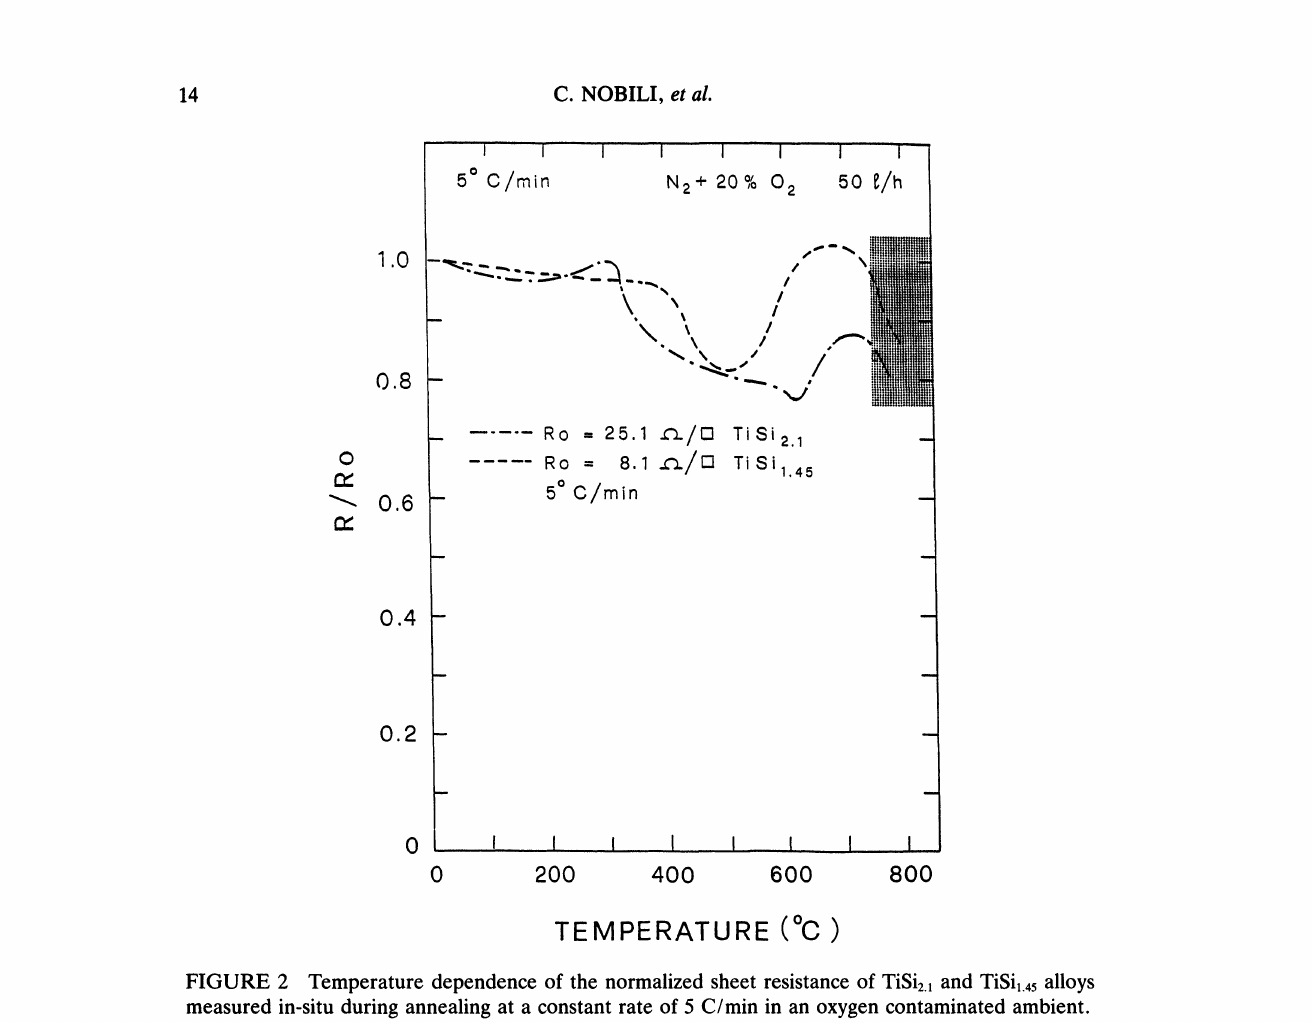
FIGURE 2 Temperature dependence of the normalized sheet resistance of TiSi2.1 and TiSil.45 alloys measured in-situ during annealing at a constant rate of 5 C/min in an oxygen contaminated